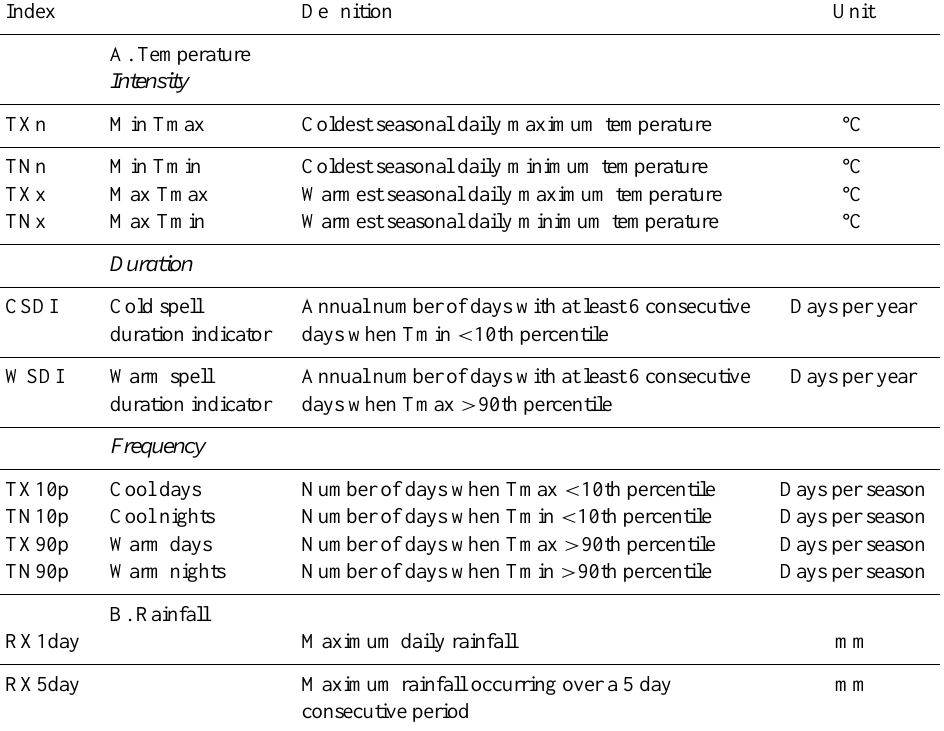
Table 3. A selection of the temperature indices recommended by the ETCCDI and used in this study (definitions can be found at http://cccma.seos.uvic.ca/ETCCDI/list 27 indices.shtml). Note that ETCCDI expresses the temperature frequency indices (TX10p, TN10p, TX90p and TN90p) in percentages, but the scale used here is in number of days per 3-month season (DJF, MAM, JJA, SON). Differences in the percentile-based indices (including WSDI and CSDI) relate to the 10th and 90th percentiles of simulation